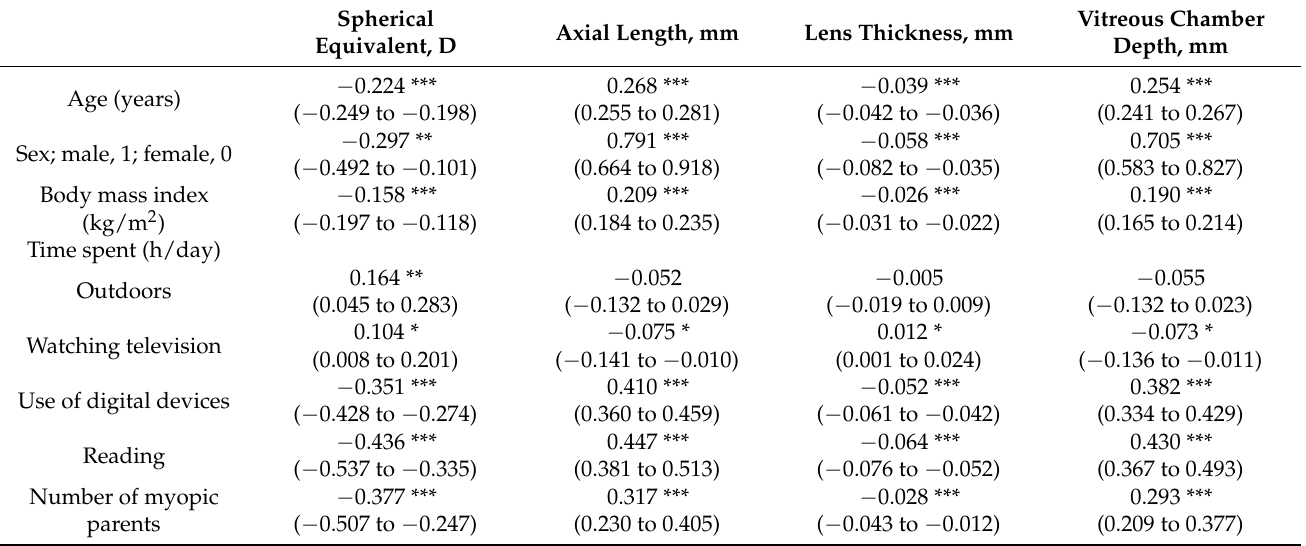
Table 3. The associations between ocular parameters and lifestyle by simple linear regression